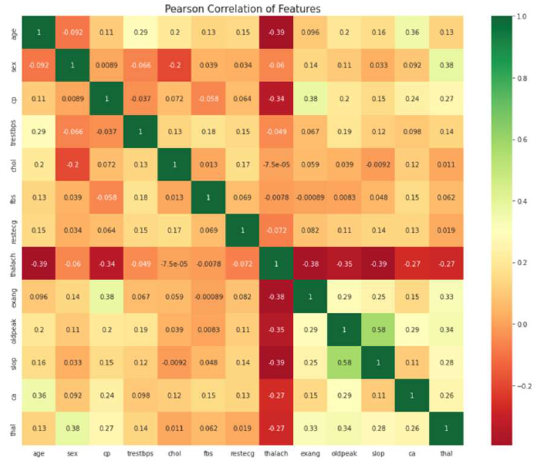
Figure 3: Heart Correlation Matrix